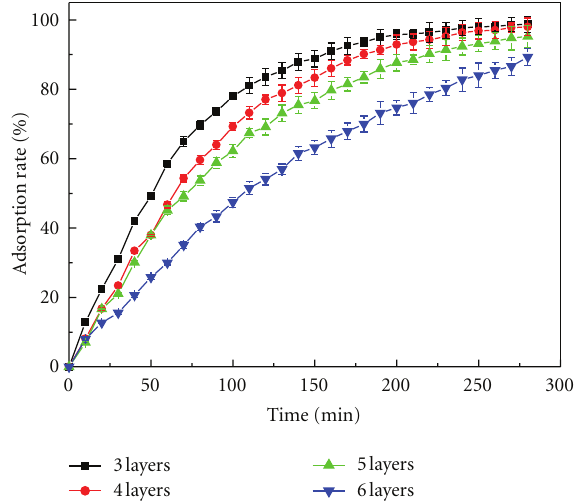
Figure 6: E ff ect of the TiO 2 film layers on adsorption capacity of the membranes for MB: the substrate is PAN composite nanofibrous membranes with 3 wt.%